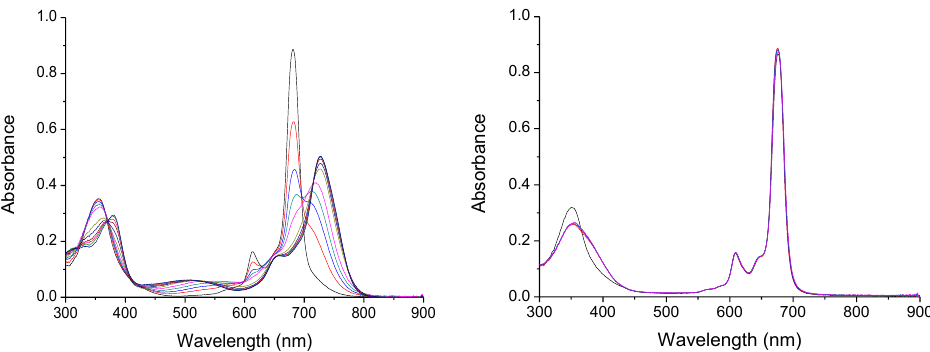
Figure 3. Absorption spectra of Pc1 (5.4 × 10 −6 mol.dm −3 ) in DMSO upon addition of increasing concentration of CN − (5.4 × 10 – 6 mol.dm – 3 ) (left) and Cl − (4.3 × 10 – 3 mol.dm – 3 ) (right). During the titrations of the chemosensor Pc1 , a drastic change was noticed in the solution color, from green to violet in the presence of AcO − , F − , H 2 PO 4 − , and OH − , to blue when in the presence of NO 2 − and to the most distinct and notorious a pale-yellow, when in the presence of CN − (Figure 4). These color changes confirm the ability of Pc1 to act as optical chemosensor.